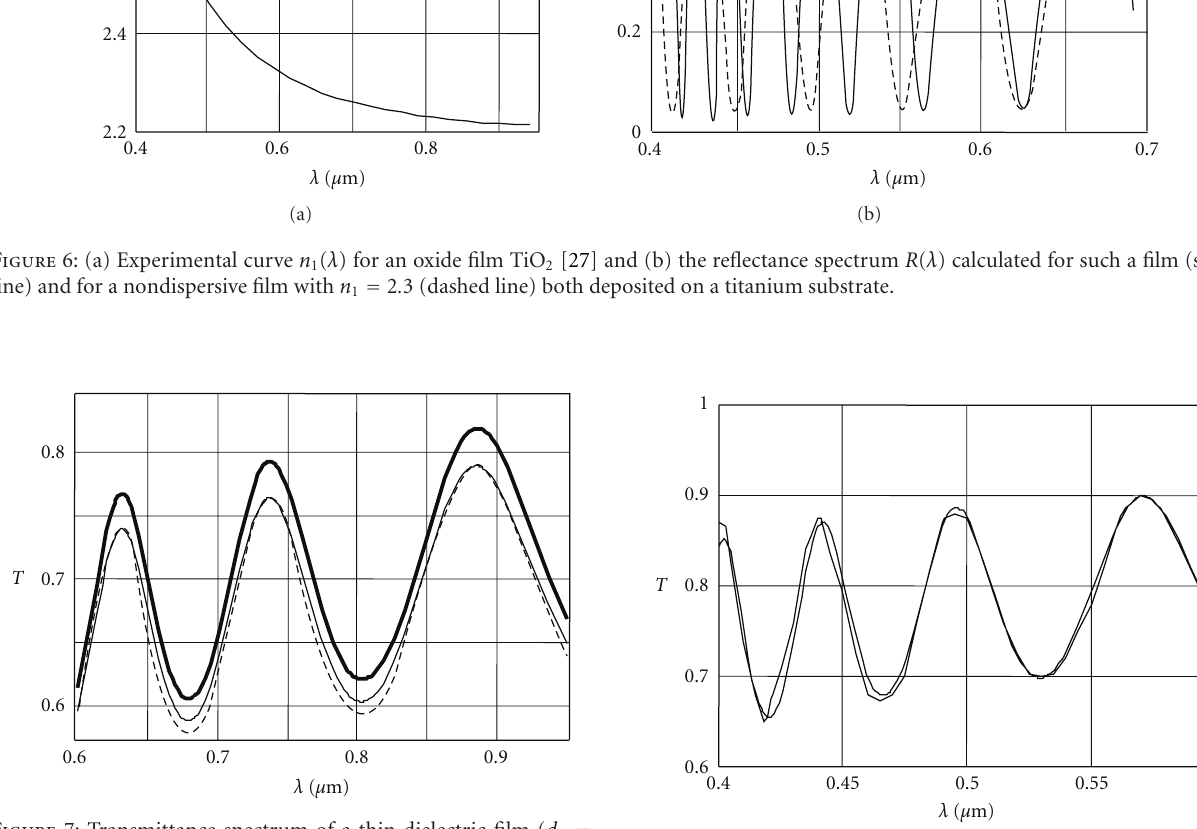
Figure 8: Experimental transmittance spectrum of an oxide film Ta 2 O 5 on a quartz-glass substrate (thin line) and the spectrum T ( λ ) calculated from (93) for the 4M structure (thick line) by using d 1 = 0 . 824 μm , n 1 ( λ ) and k 1 ( λ ) in the form of (97) which are obtained from the experimental